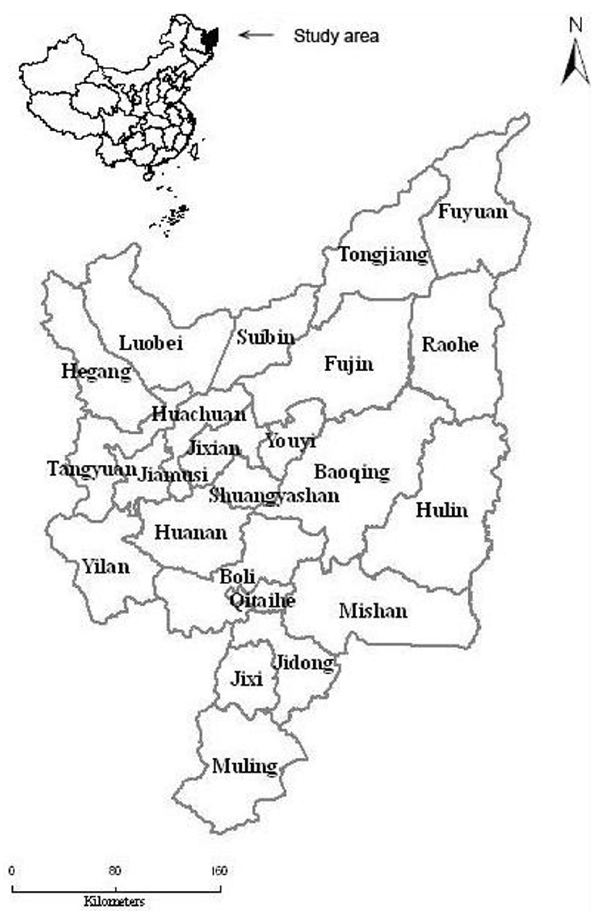
Fig. 1. The study area on the Sanjiang Plain of northeast China, covering 23 counties and 3 administrative